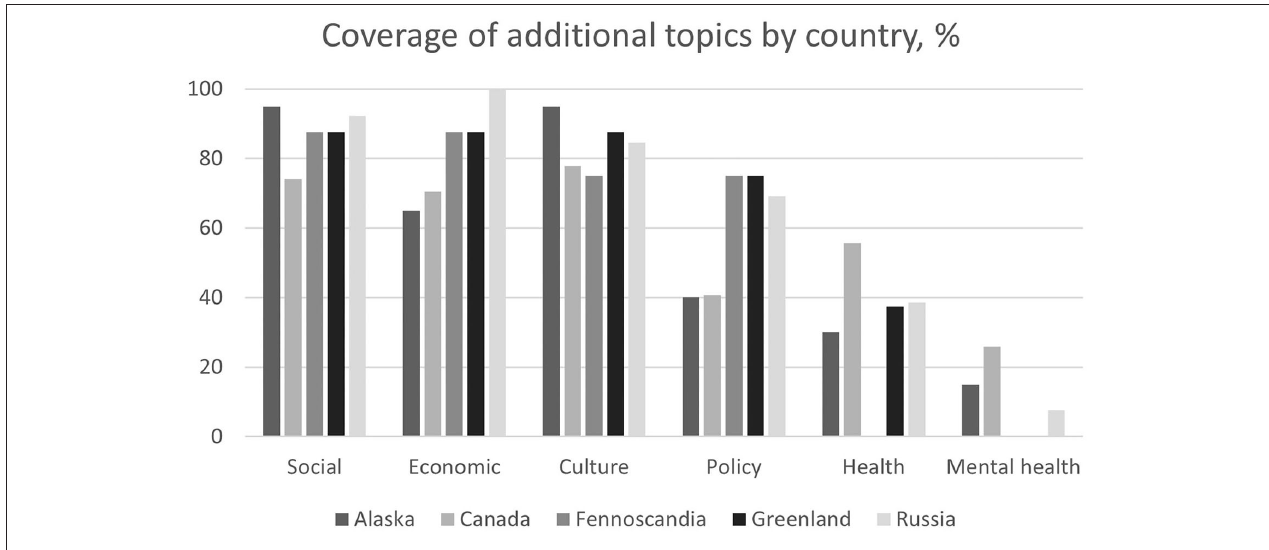
FIGURE 4 | Coverage of additional topics by country, % of total